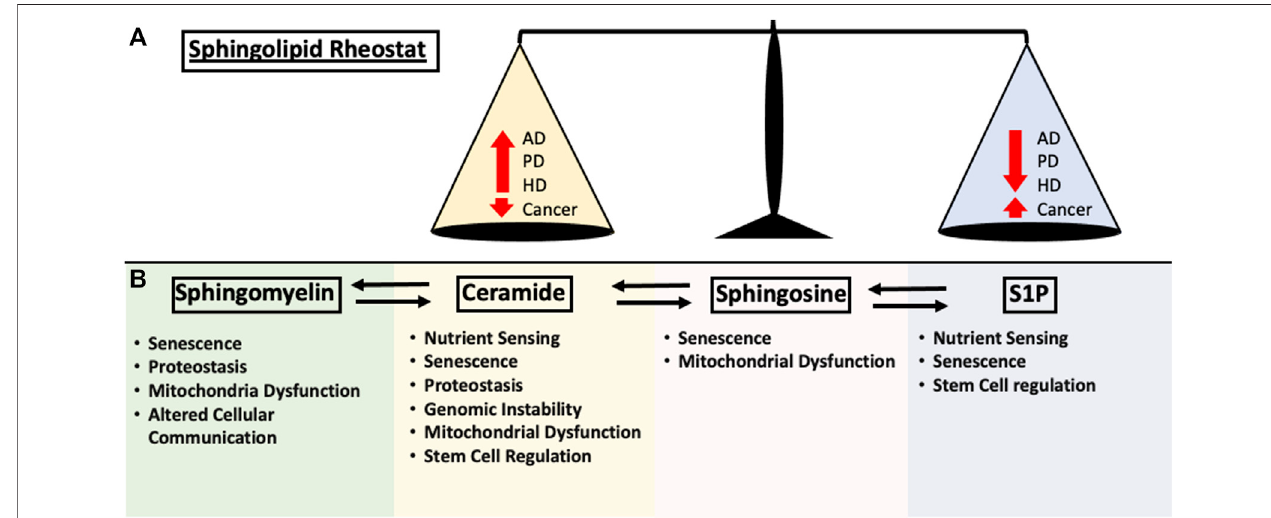
FIGURE 2 | Summary of the impact each sphingolipid species have on the hallmarks of aging discussed in this review. (A) Early sphingolipid research uncovered the differential regulation of cell fate through the modulation of signaling pathways. Ceramide upregulation resulted in the activation of apoptosis and cell growth arrest whileS1Pisrequiredforpropercellulargrowth.Thisisnowknownasthe “ SphingolipidRheostat ” andisoneofthefundamentalconceptsofsphingolipidbiology.Inage- related disease such as Alzheimer ’ s Disease (AD), Huntington ’ s Disease (HD), Parkinson ’ s Disease (PD) and Cancer, the alterations in sphingolipid metabolism follows the rheostat. Changes in either pro-apoptotic or pro-survival signaling pathway is negatively correlated in the other. (B) Contributions of the major sphingolipid metabolites to the hallmarks of aging as mentioned in this